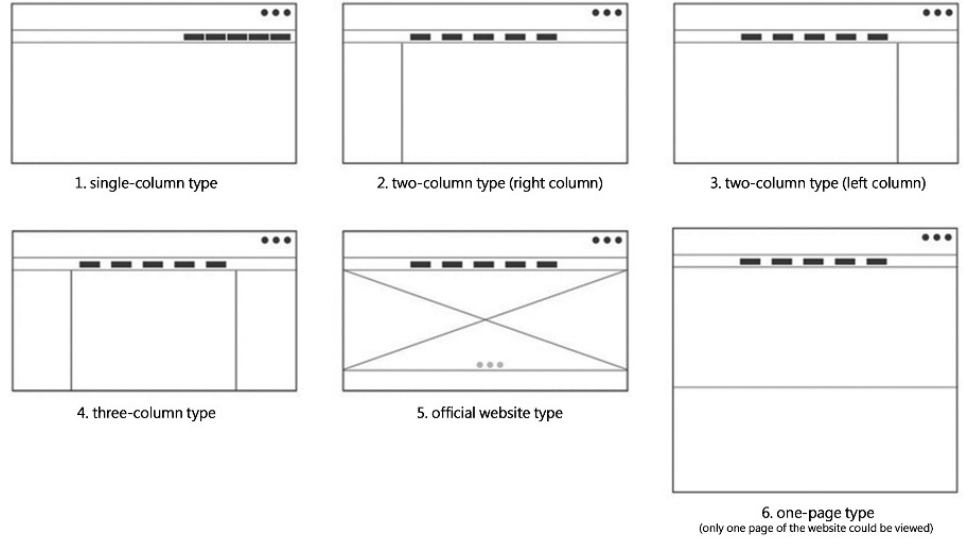
Figure 3. The self-media construction forms in the Kano questionnaire.